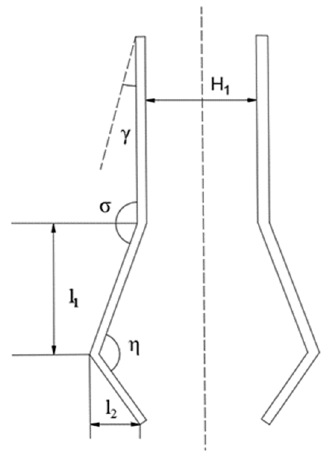
Figure 4. Structural design drawing of dividing plate.